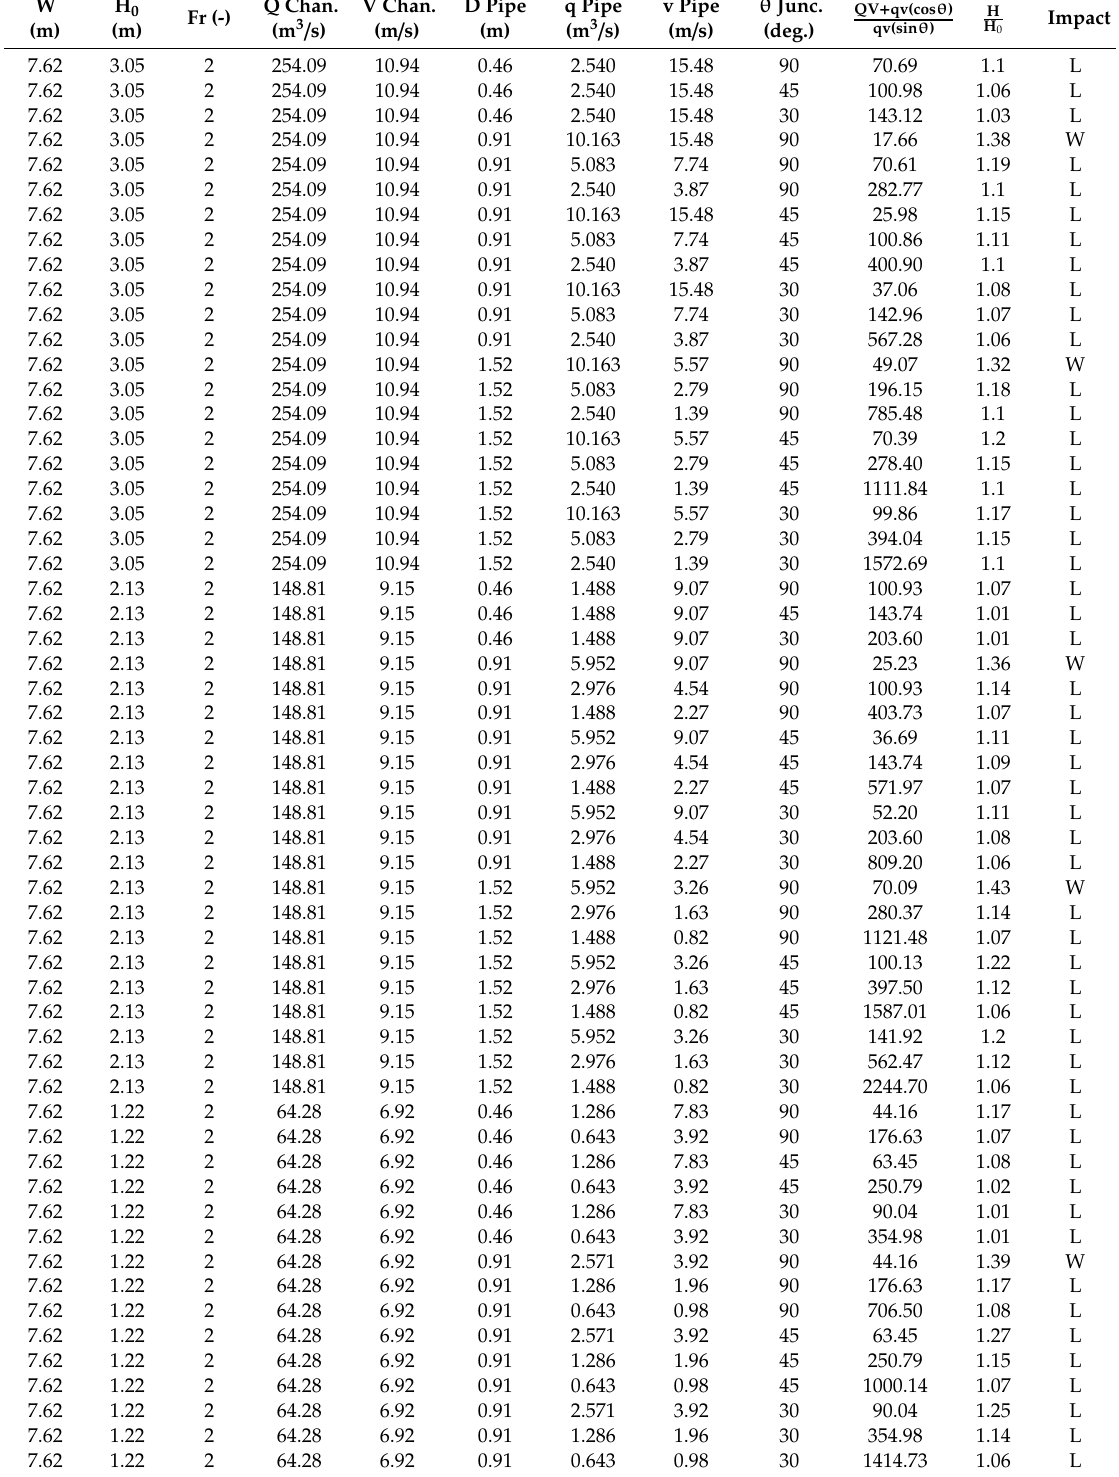
Table A2. FLOW-3D simulation results for W = 7.62 m (25 (cid:48) ) and Fr =